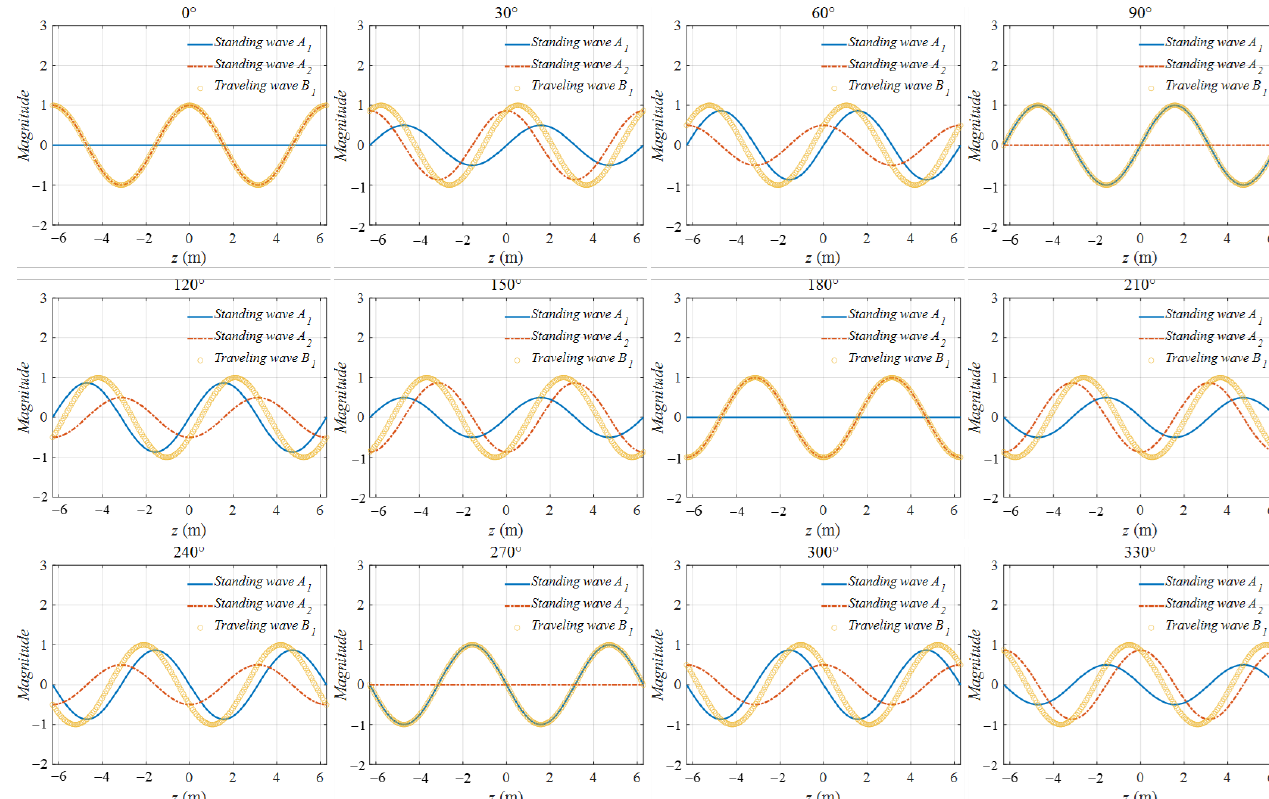
Figure 11. Phenomenon of two standing waves generating a traveling wave. In Figure 11, the blue line stands for A 1 ( z , t ) , and the dashed red line stands for A 2 ( z , t ) . Those two waves were pulsing on different z points and did not possess the wave traveling motion along the z direction when the time degree varied. However, B 1 ( z , t ) , which is expressed by the circle yellow line, moves along the z direction when the time degree varies from 0° to 180°. The animation is presented on this journal’s website. The peak points of from z = −6 .28 m to z = 0 m were